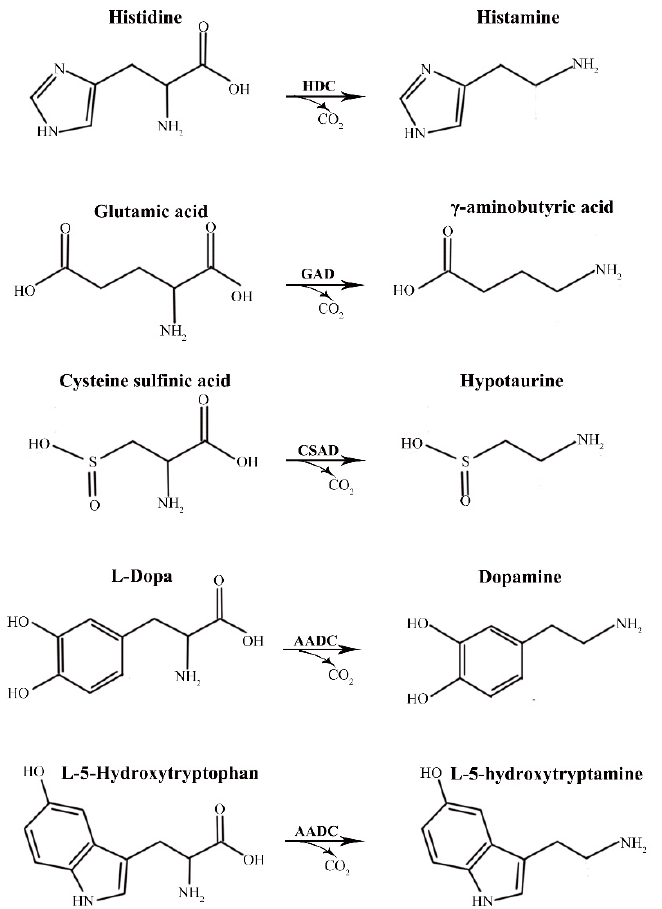
Figure 1. Substrates and products of human group II amino acid decarboxylases. HDC, histidine decarboxylase; GAD, glutamic acid decarboxylase; CSAD, cysteine sulfinic acid decarboxylase; AADC, aromatic amino acid decarboxylase.